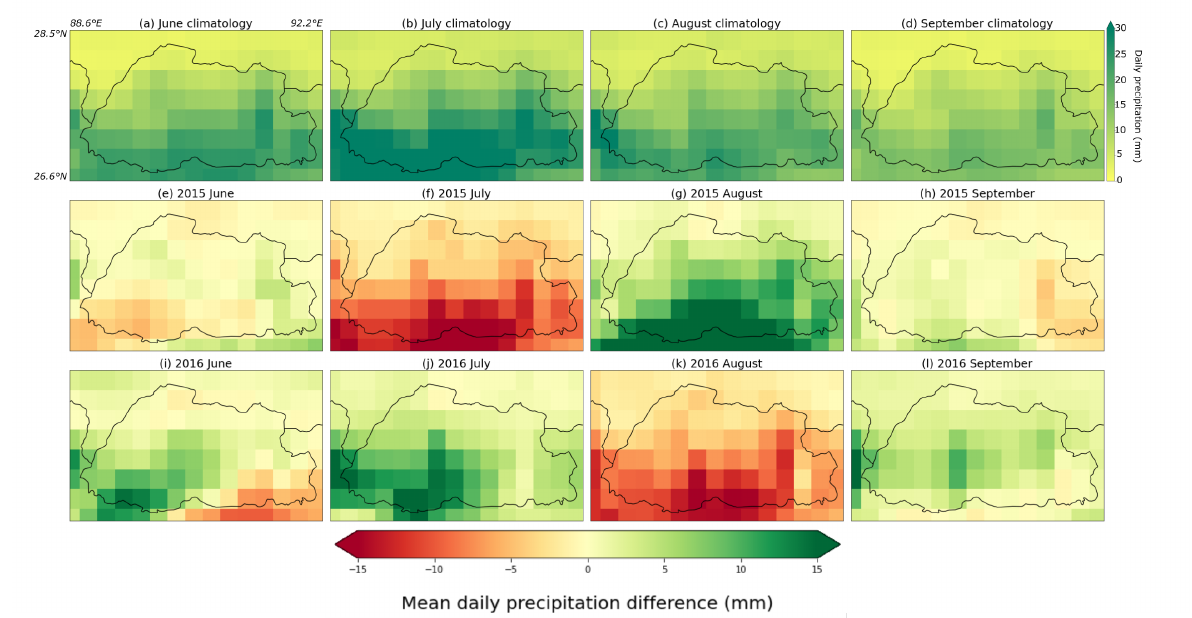
Figure 6. Precipitation (mm/day) during the monsoon season over over Bhutan. Panels textbfa to textbfd show the climatology based on 1979 to 2018 JJAS data. Panels e to h and i to m show the mean monthly 2015 and 2016 difference of precipitation respectively, calculated by subtracting the 2015 or 2016 monthly values from the 40-year climatology